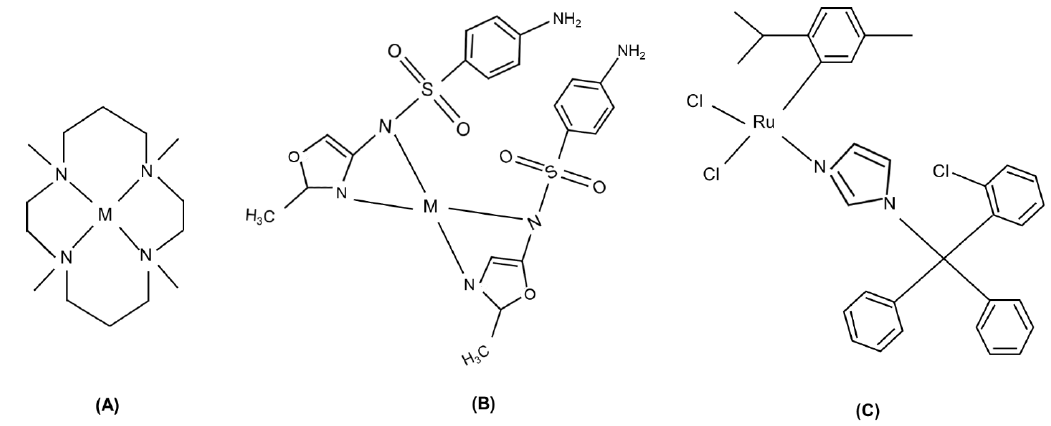
Figure 2. Several examples of metal-drug complexes: ( A ) cyclam derivatives, M = M n+ , ( B ) sulfonamide complexes, M = M n+ , ( C ) ruthenium-clotrimazole metal complex. Sulfadoxine is a sulfonamide used in combination with pyrimethamine to treat malaria caused by the Plasmodium falciparum parasite [107]. Pyrimethamine and sulfadoxine target two enzymes that dihydropteroatesynthetase (DHPS). With respect to this, cobalt, copper, nickel, and zinc complexes of